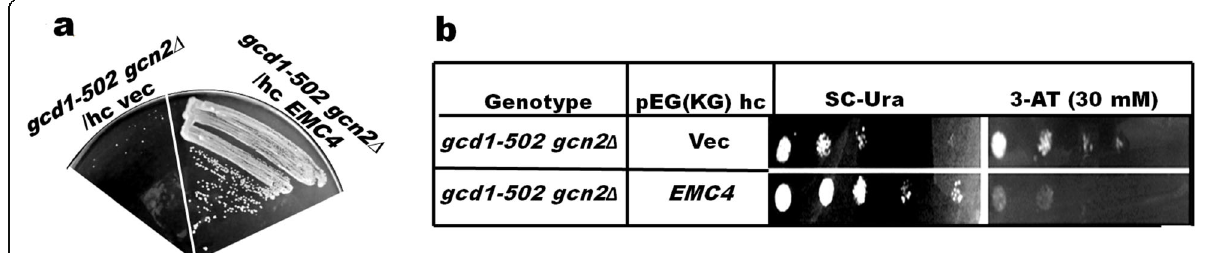
Fig. 2 Effect of Emc4p expression on eIF2B mutants. gcd1-502 gcn2 Δ mutant strain rescued Ts + , Slg + , and Gcd + phenotype when transformed with hc/ EMC4 . ( a ) gcd1-502 gcn2 Δ transformants showing Slg + phenotype at 37 °C were streaked along with gcd1-502 gcn2 Δ transformed with hc vector, pEG (KG). ( b ) Serial dilutions of the transformants showing Slg + phenotype were spotted on SC-Ura and SC medium containing 30 mM- 3AT. gcd1-502 gcn2 Δ transformed with hc vector, pEG(KG), was spotted as a control. Plates were incubated for 2 days at 30